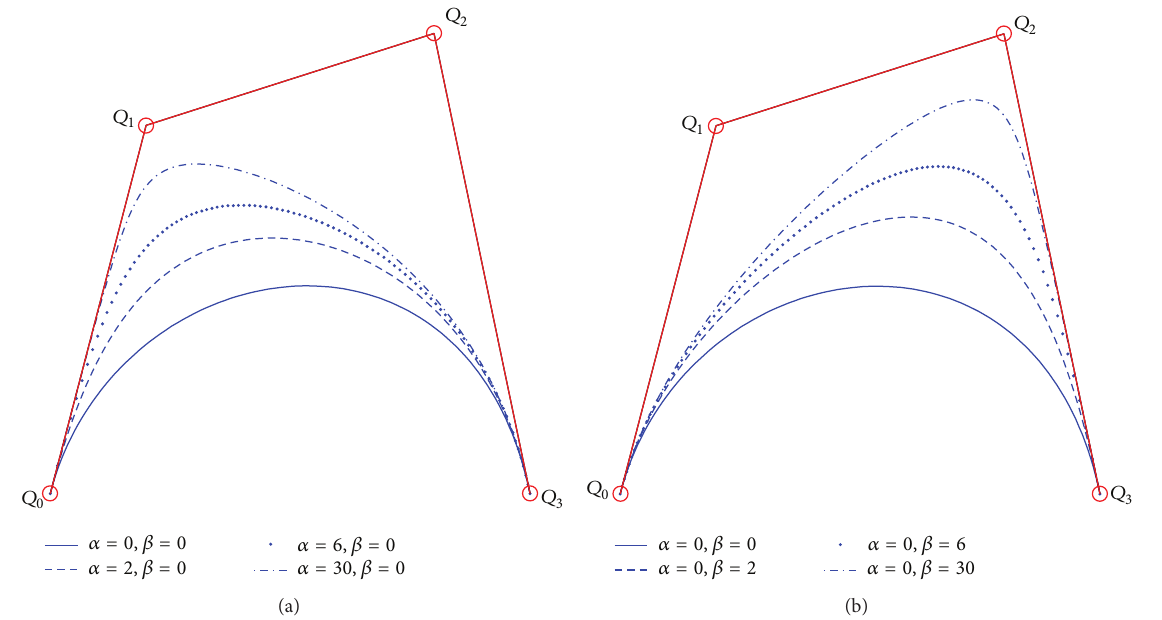
Figure 2: The effect of shape parameters on the quartic rational Said-Ball-like